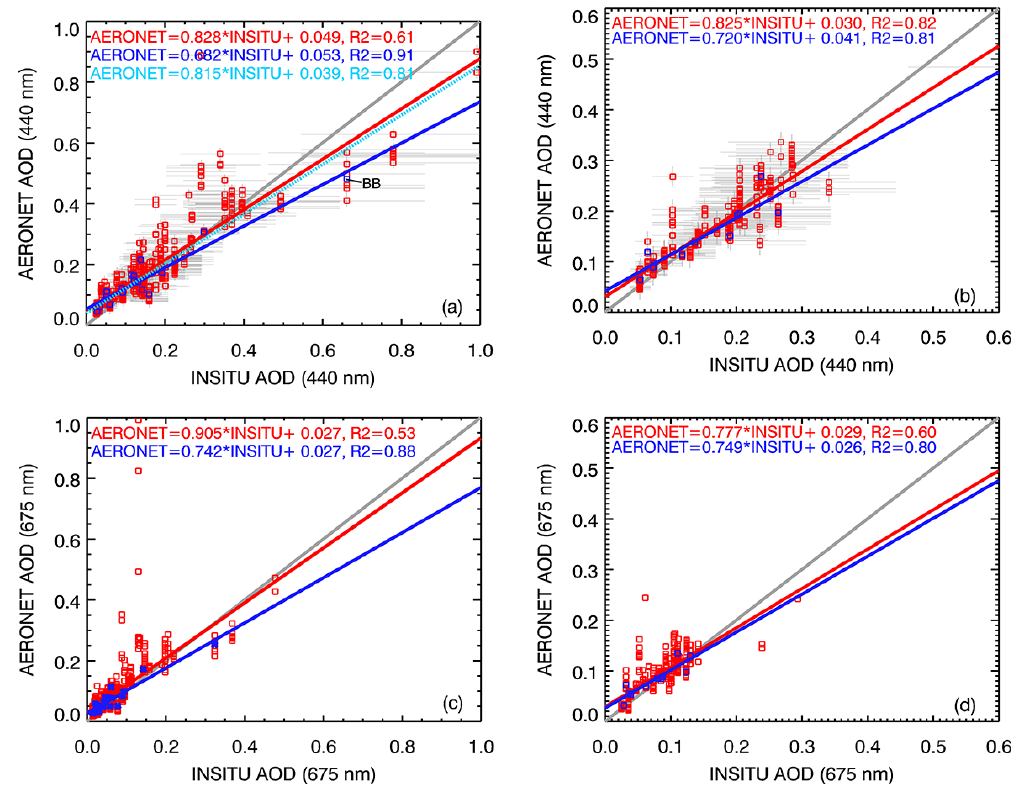
Figure 4. AOD comparison (a) BND at 440nm, (b) SGP at 440nm, (c) BND at 675nm and (d) SGP at 675nm; thick gray line is 1-to-1 line. Thin gray lines associated with each data point represent measurement uncertainties. Red points and fit line represent all AERONET direct-sun Level 2 AOD measurements within ± 3h of the end of the profile. Blue points and fit line represent the average of AERONET Level 2 AOD measurements with successful almucantar retrievals within ± 3h of the end of the profile. The light blue dashed line is the fit when the BB point is excluded. Note: two BND direct-sun AOD440 points corresponding to the two highest AOD675 points in (c) are off the scale of the plot and not shown. The third high AOD440 point is partly obscured by the